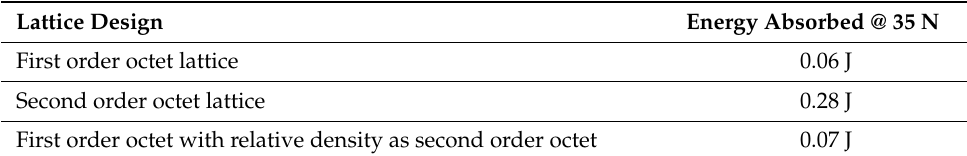
Table 2. Effect of introducing a hierarchy on the energy absorption.